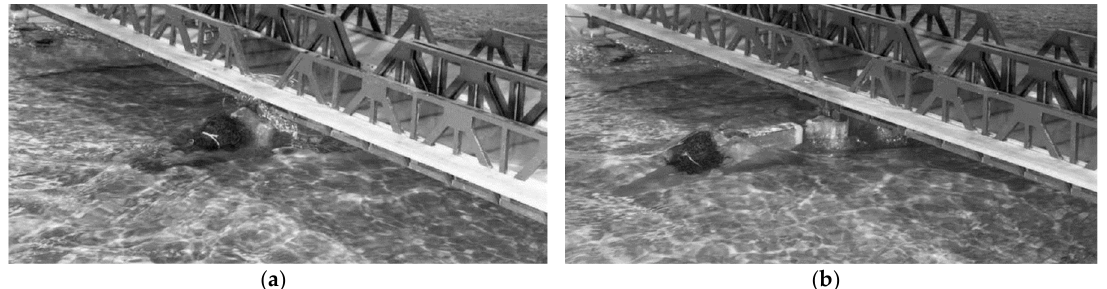
Figure 2. ( a ) Flow conditions in 1:50-scale model of the Rio Hondo River, debris on bridge pier, ( b ) Flow conditions in 1:50-scale model of the Rio Hondo River, debris on extended bridge pier [3].